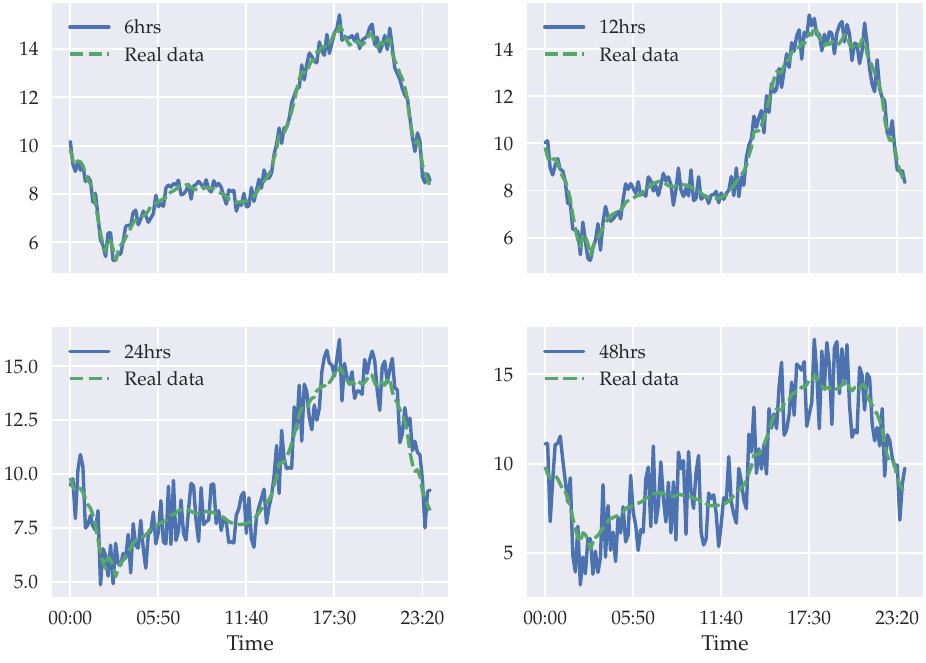
Figure 9. GRAST-Frost model results compared with that of real data for 6, 12, 24, and 48 h forecasts. In this case our model also outperforms all the baselines for the 6 h, 12 h, 24 h, and 48 h tasks. In addition, similar to regression, models performance decreases when time- window